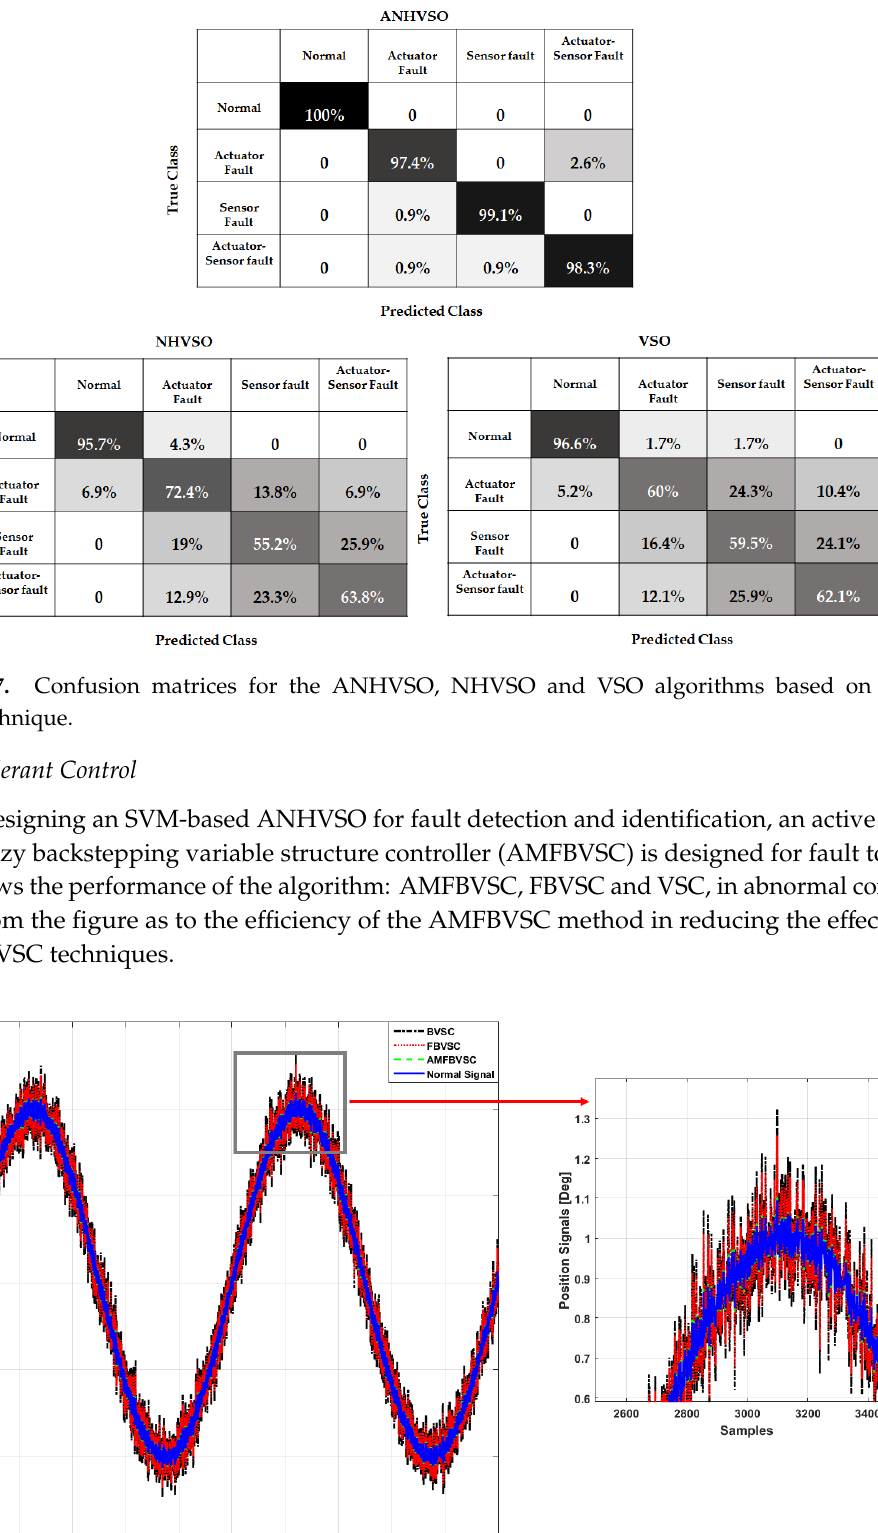
Figure 6. Energy of the torque and position residual sig nals of robot manipulator’s joints considering four different conditions for fault classification.